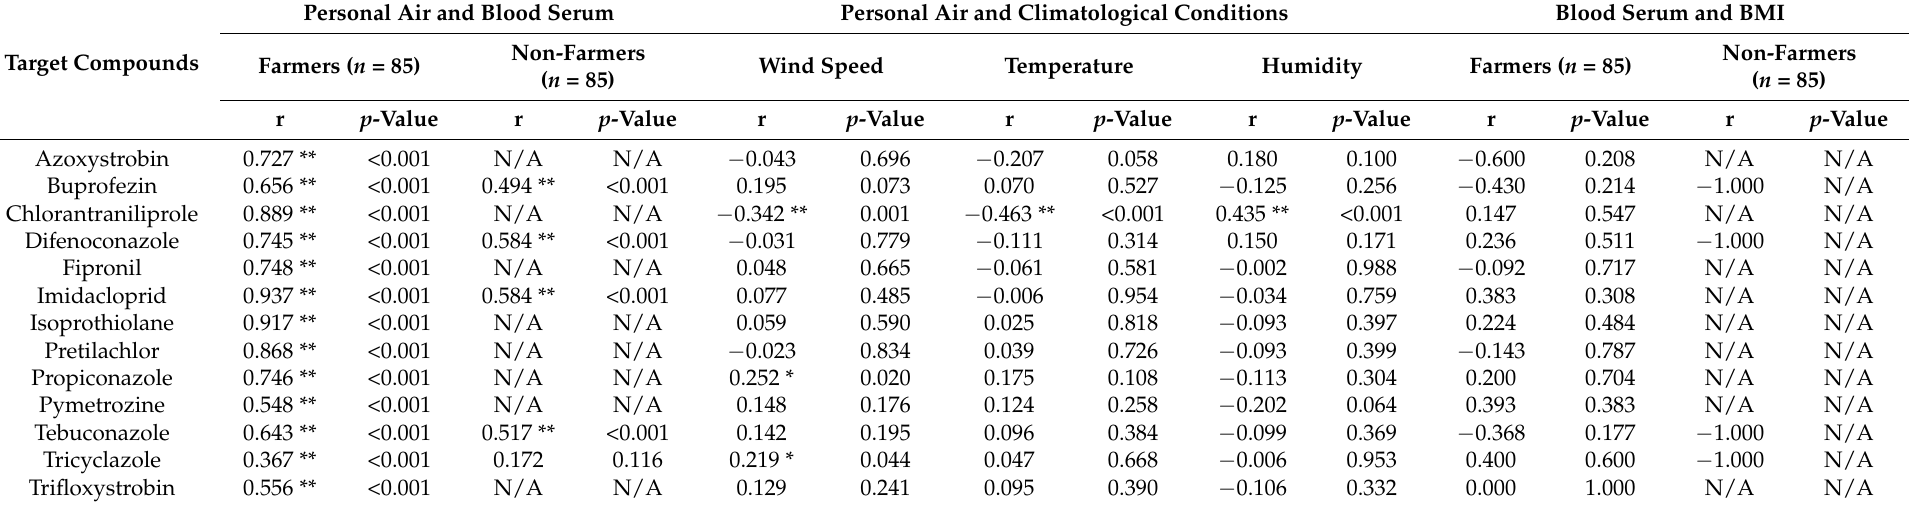
Table 7. Correlation between pesticides concentration in personal air with blood serum and climatological conditions, and pesticides concentration in blood serum with